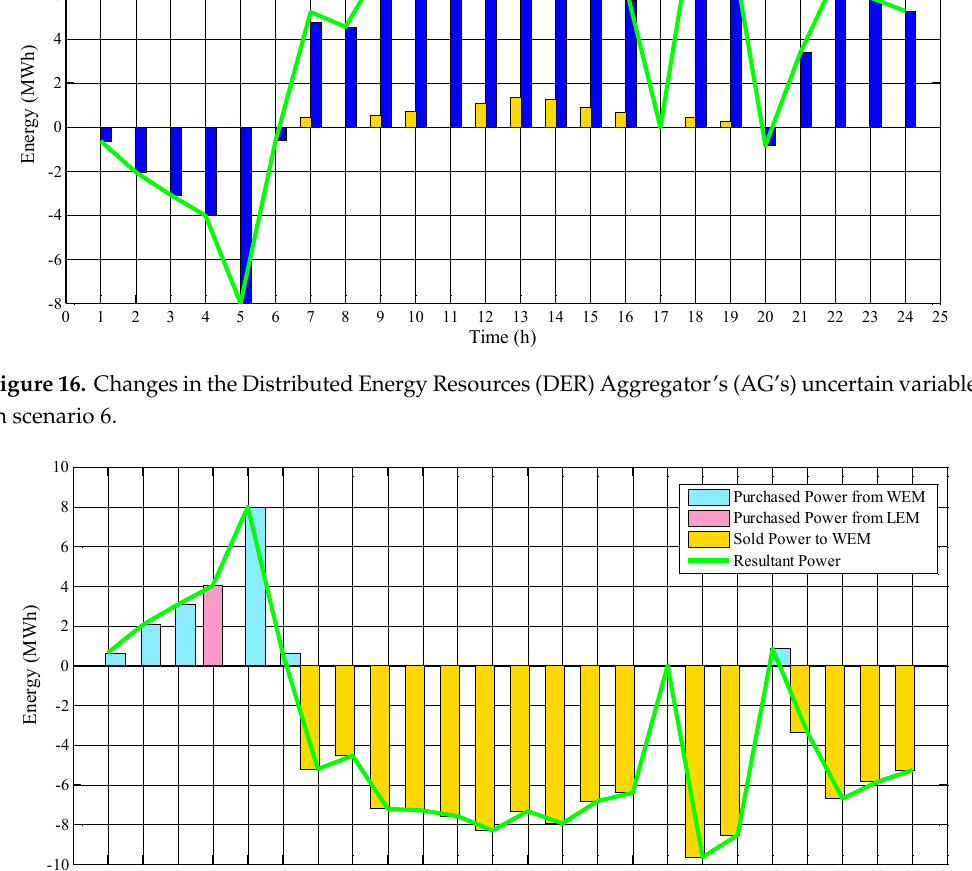
Figure 17. AG’s traded energy in the RT markets for scenario 6 considering the competitive environment.